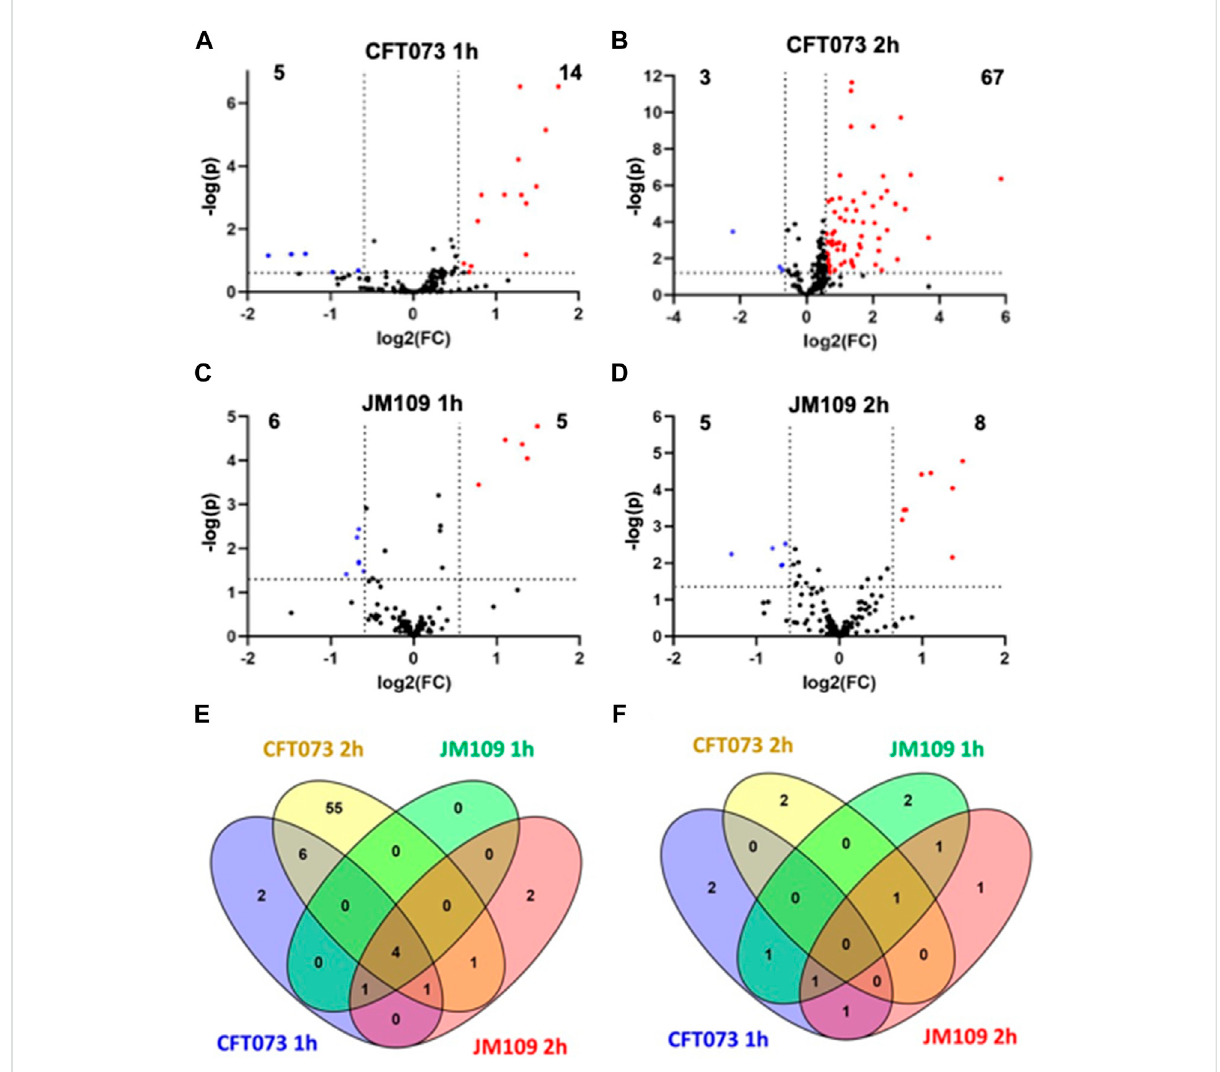
Untargeted lipidomics reveal changes in lipidomes during bacteria endothelial coculture (2-cell system). Volcano plots are shown comparing cocultureconditionstotherespectivecombinedcontrolcultures.CFT073cocultureswerecomparedtoCFT073combinedcontrolat1 h (A) and2 h (B) cocultureintervals.JM109cocultureswerecomparedtoJM109combinedcontrolat1 h (C) and2 h (D) cocultureintervals.Statisticalsigni fi cance for A, B, C and D were evaluated by t -test ( p- value < 0.05) and fold change (FC) threshold at 1.5 (E) Venn diagram representing increased